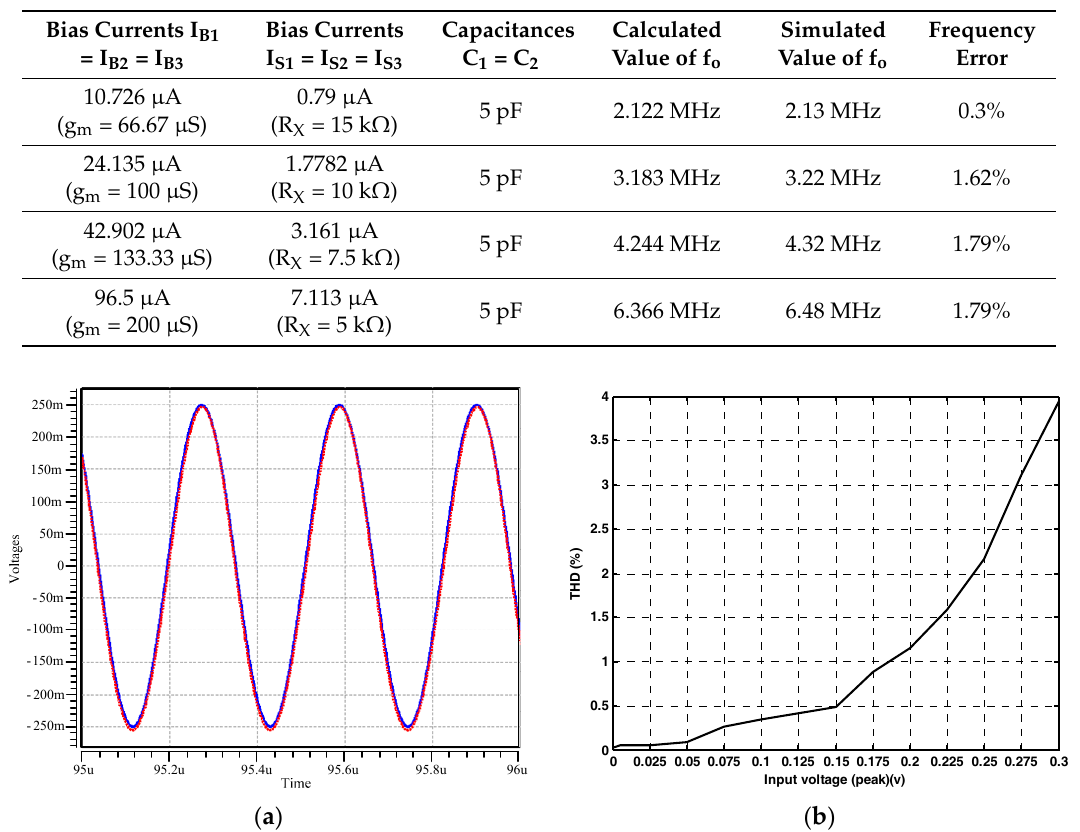
Figure 12. Time-domain results of VM bandpass filter at the output V o 2 of Figure 2 ( a ) input (blue line) and output (red line) waveforms; ( b ) total harmonic distortion (THD) analysis results on input voltage at 3.183 MHz. Table 8. Component values used to obtain a specified f o .